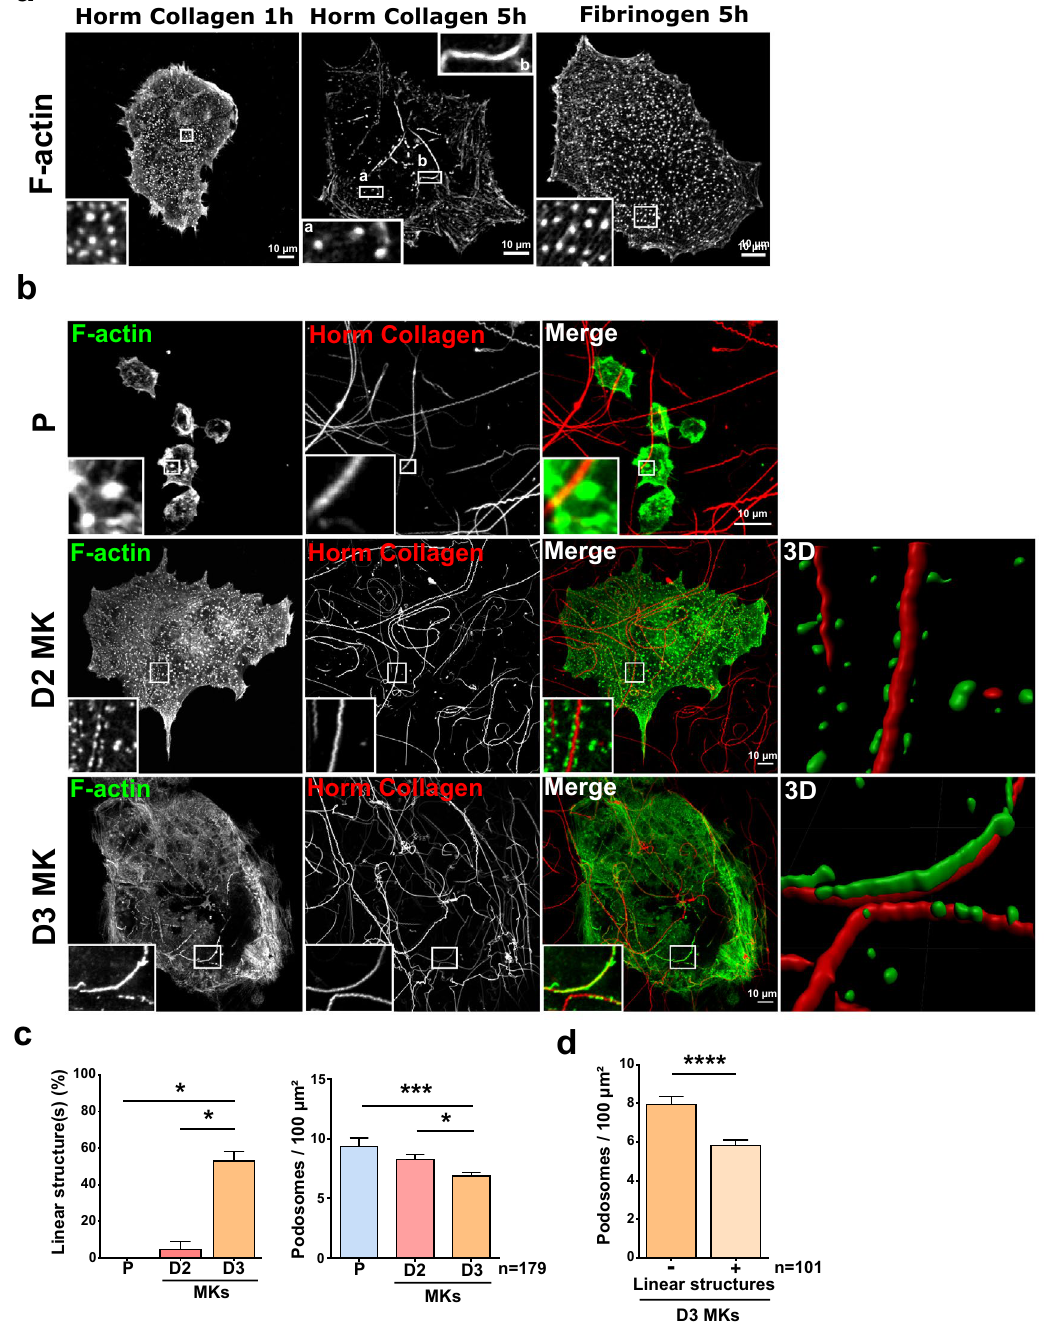
Figure 1. Mature MKs form linear F-actin structures on fibrillar collagen I. ( a ) MKs were spread for 1 h or 5 h on glass surface coated with 100 µg/ml Horm collagen or 100 µg/ml fibrinogen. Cells were then fixed and permeabilized before staining for F-actin. Box a shows dot-like podosomes, box b shows linear actin structure along the collagen I fiber. Scale bars = 10 µm. ( b ) Representative confocal images of Lin − progenitor (P), MKs differentiated for 2 days (D2MK), or 3 days (D3MK) with mTPO (50 ng/ml), cultured on 100 µg/ml labelled- Horm collagen, scale bars = 10 µm. 3D corresponds to a 3D surface rendering of the zoomed areas using the IMARIS software. ( c ) Quantification of the percentage of cells with linear F-actin structures and of dot-like podosomes (podosomes) density according to the indicated maturation time. Values are from 4 independent experiments. ( d ) Quantification of dot-like podosomes (podosomes) density (for 100 µm 2 ) among D3MKs according to the presence (+) or not (−) of linear F-actin structures. Values (mean ± S.E.M.) are from 4 independent experiments. *P < 0.05, ***P < 0.001 according to the Kruskall–Wallis test, ****P < 0.0001 according to the Mann–Whitney test. n = number of cells